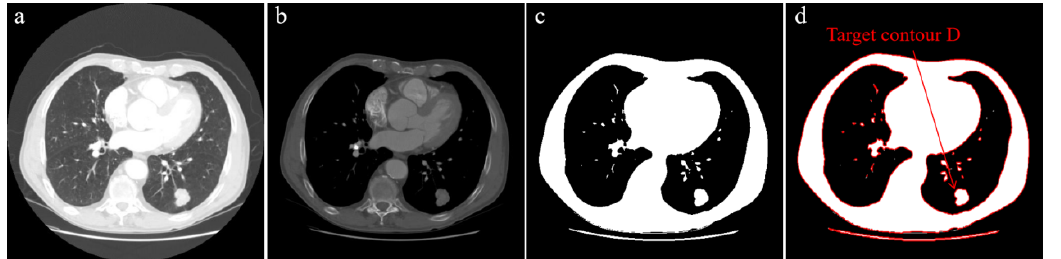
Figure 1. Automatic selection of initial seed point, ( a ) input image, ( b ) preprocessed image, ( c ) binary image, ( d ) after extracting all contours, find the contour that conforms to the attribute and set it as target contour D , with its centroid as the initial seed point p1.